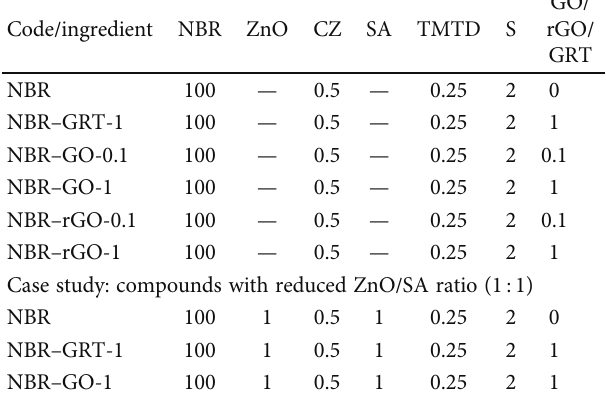
Table 1: The compositions without ZnO/SA and compounds with reduced